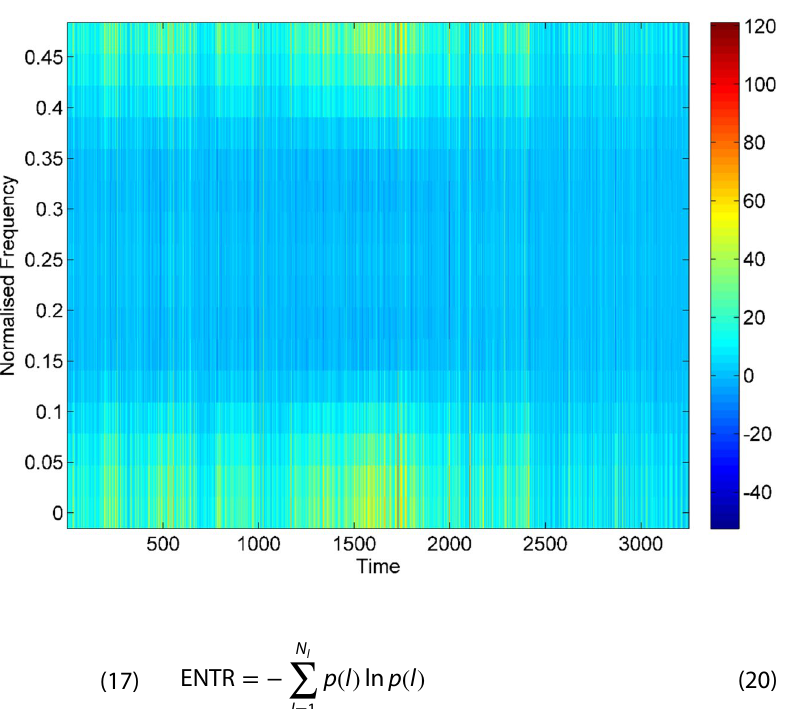
Fig. 2 SPWVD of the Planetary K -index time